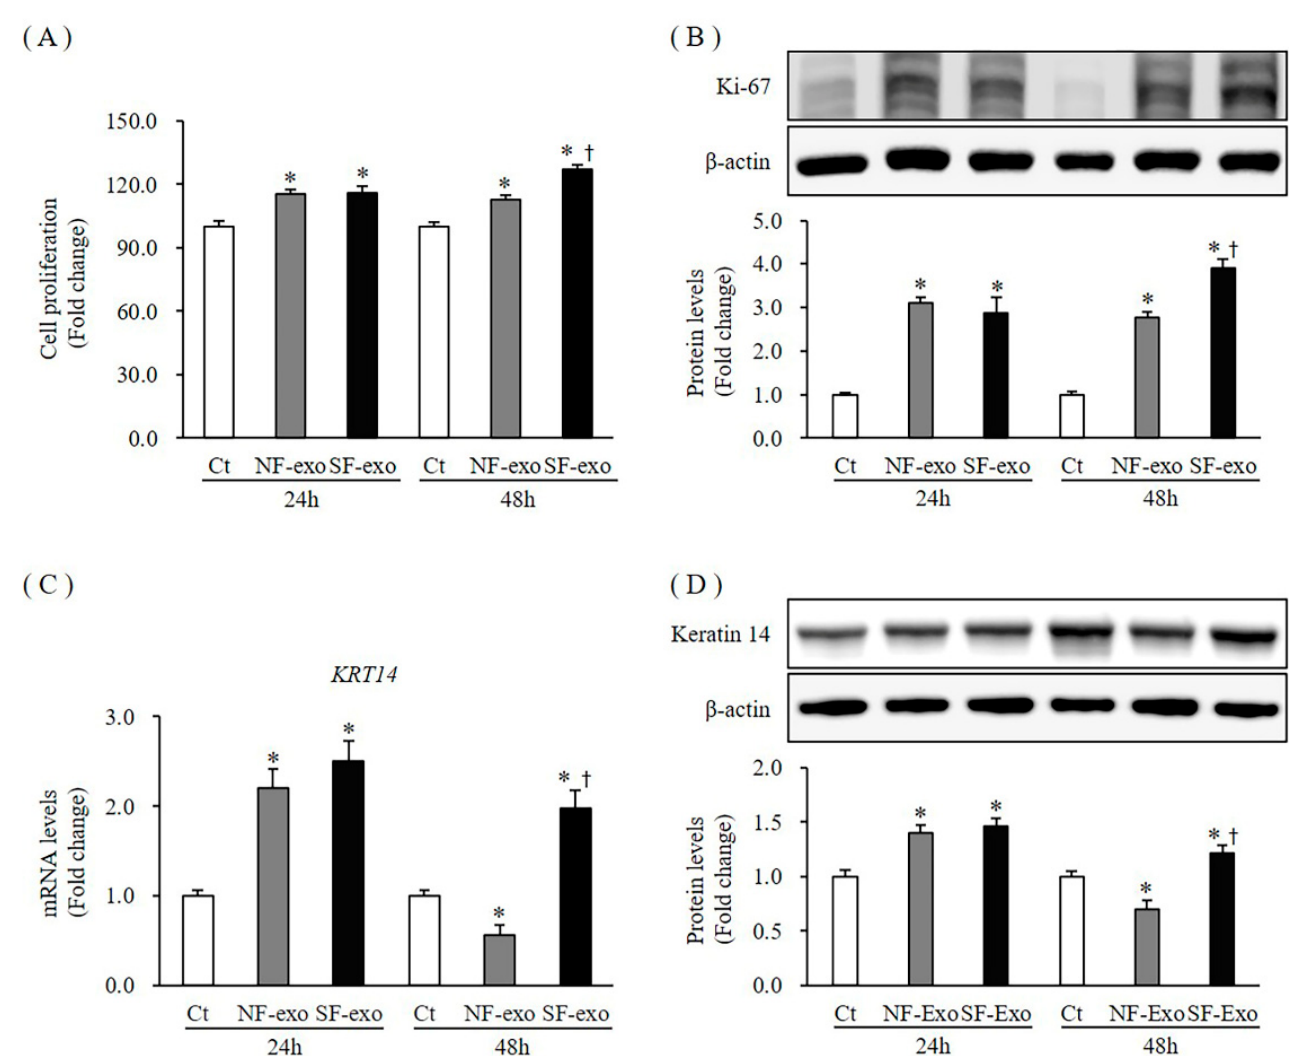
Figure 2. Cell proliferation and expression of proliferation markers in normal human keratinocytes (NHKs) after NF- and HTSF-exosome treatment. NHK proliferation increased significantly at 24 and 48 h after treatment with 100 µ g/mL NF- and HTSF-exosomes, respectively, compared with Dulbecco phosphate-buffered saline (DPBS)-treated control cells; there was a significant difference between NF- and HTSF-exosome treatment at 48 h ( A ). For the fold change, control cells were marked by a value of 100%. The cell proliferation assay was performed in triplicate. Protein expression of Ki-67 ( B ) and the mRNA and protein expression of keratin 14 ( KRT14 ; C , D ) in NHKs increased significantly at 24 and 48 h after treatment with 100 µ g/mL HTSF-exosomes, except for NF-exosomes at 48 h, compared with that in the control cells. * p < 0.05 for NF- or HTSF-exosome-treated cells versus the corresponding matched control cells. † p < 0.05 for HTSF-exosome-treated cells versus NF- exosome-treated cells. Data represent the mean ± standard deviation (SD); n = 4. Ct, DPBS-treated control cells; NHK, normal human keratinocytes; NF-exo, normal tissue-derived fibroblast exosomes; SF-exo, hypertrophic scar tissue-derived fibroblast exosomes. 2.3. Effects of NF- and HTSF- Exosomes on Expression of Activation Markers in NHKs KRT6 and KRT16/17 have been defined as activation markers [28]. Both the mRNA and protein expression levels of KRT6 in NHKs increased at 24 h after treatment with NF- and HTSF-exosomes, respectively, compared with those in DPBS-treated cells (mRNA expression increased by 3.2- and 2.93-fold at 24 h in response to 100 µ g/mL NF- and HTSF- exosomes, respectively; protein levels increased by 2.96- and 2.68-fold at 24 h in response